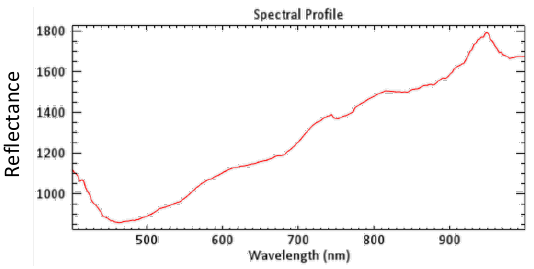
Figure 8: Target spectra of photovoltaic panels.